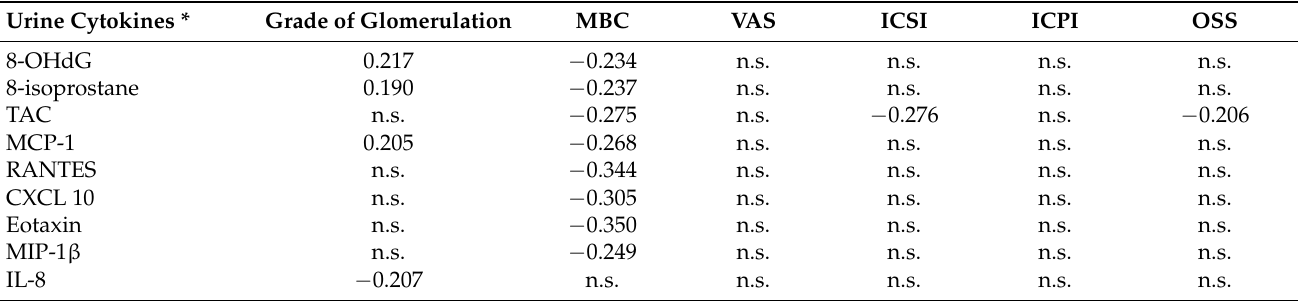
Table 6. The correlation coefficient (r-value) between urine biomarker levels and the clinical charac- teristics in patients with ESSIC type 2